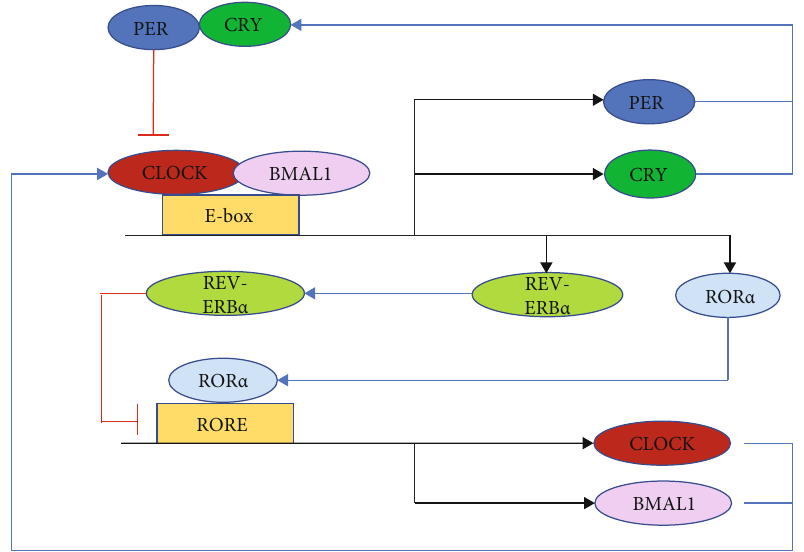
Figure 2: Molecular rhythm mechanism of the biological clock